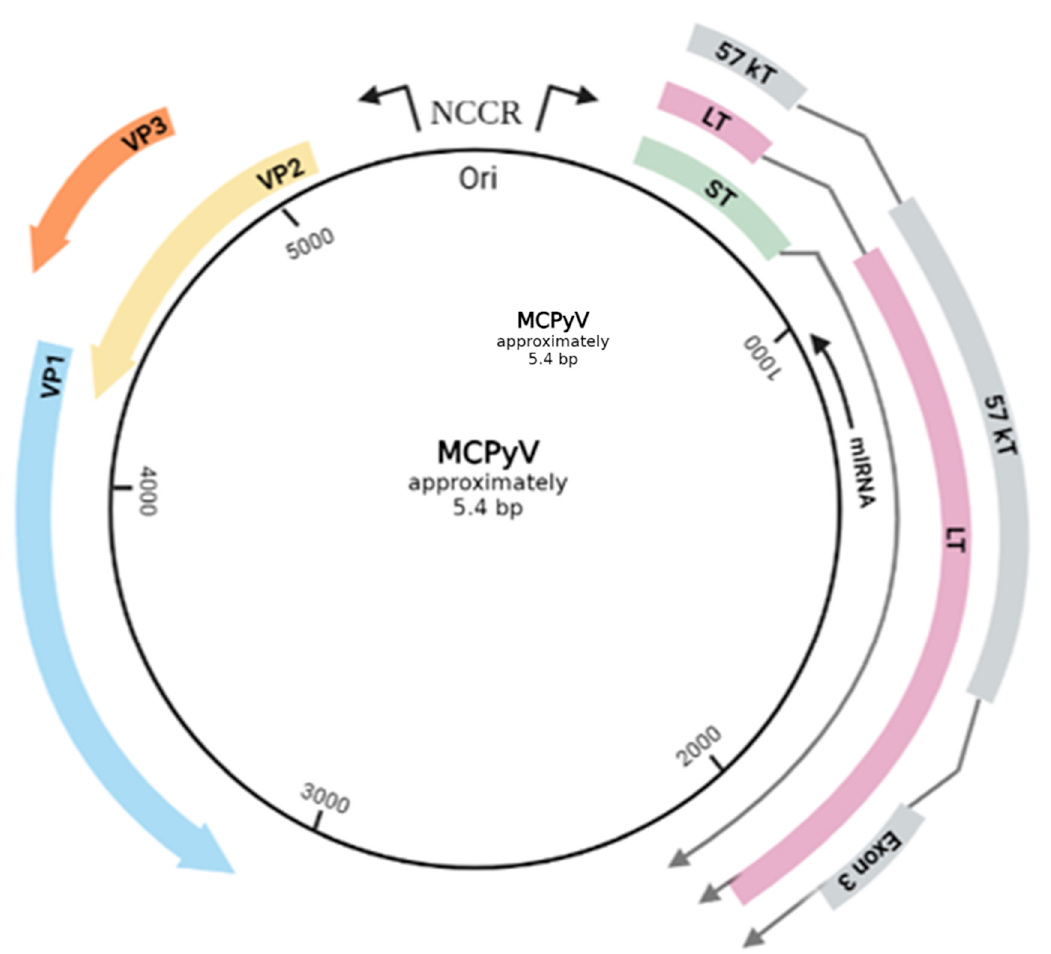
Figure 1. The genomic map of MCPyV circular, double stranded DNA. The early genes encode oncogenic proteins (LT, sT, 57 kT) and the late genes structural proteins (VP1. VP2, VP3). The NCCR (non-coding control region) includes Ori and regulates the viral gene expression. A gene, located on the late strand of the T antigen genes, with an opposite transcription orientation (reversed complementarity) to the T antigens produces a non-coding miRNA. The total length of the viral genome is approximately 5.4 bp. Created with BioRender.com (visited on 1 July